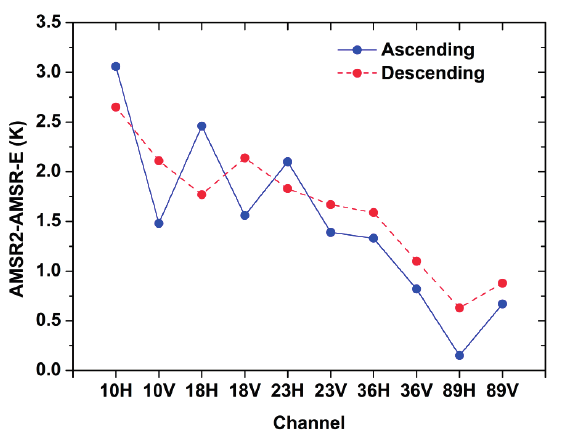
Figure 4. Global mean biases (Unit: Kelvin) between AMSR2 and AMSR-E estimated from overlapping AMSR and MWRI records for well correlated ( R > 0.95) pixels for each frequency and polarization (blue line is for the ascending orbits and red line for descending orbits).